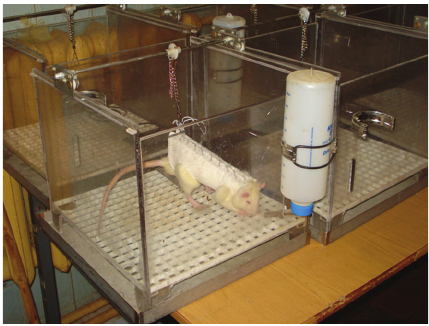
Figure 2: Simulation of microgravitation. Rat from experimental group 4. 1st day of